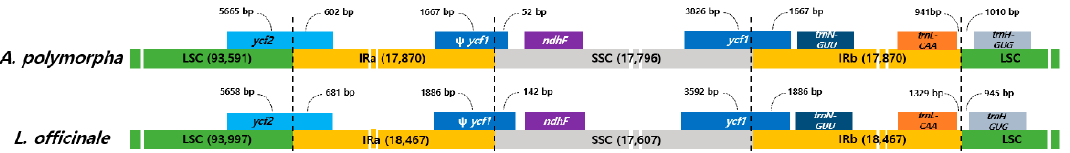
Figure 2. Comparison of CP genome sequences of A. polymorpha and L. officinale at the junctions of the LSC, IR (IRa and IRb), and SSC regions. ψ : pseudogenes.